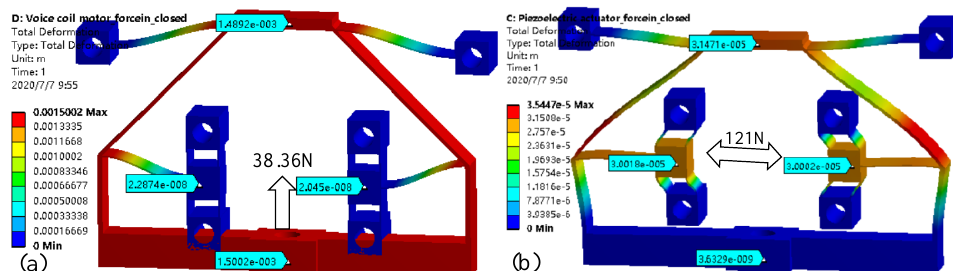
Figure 3. Displacement distribution of ACPM while ( a ) actuating the input end of VCM with 38.36 N and fixing the input end of PEA, ( b ) driving the input end of PEA with 121 N and fixing the input end of VCM. Table 2. Performance of the ACPM virtual prototype.